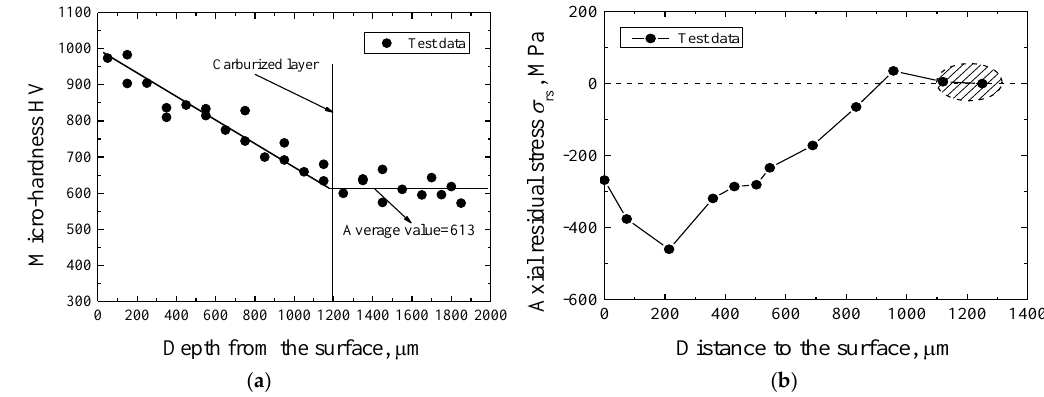
Figure 3. Distribution of microhardness and residual stress: ( a ) distribution of microhardness; ( b ) distribution of residual stress.